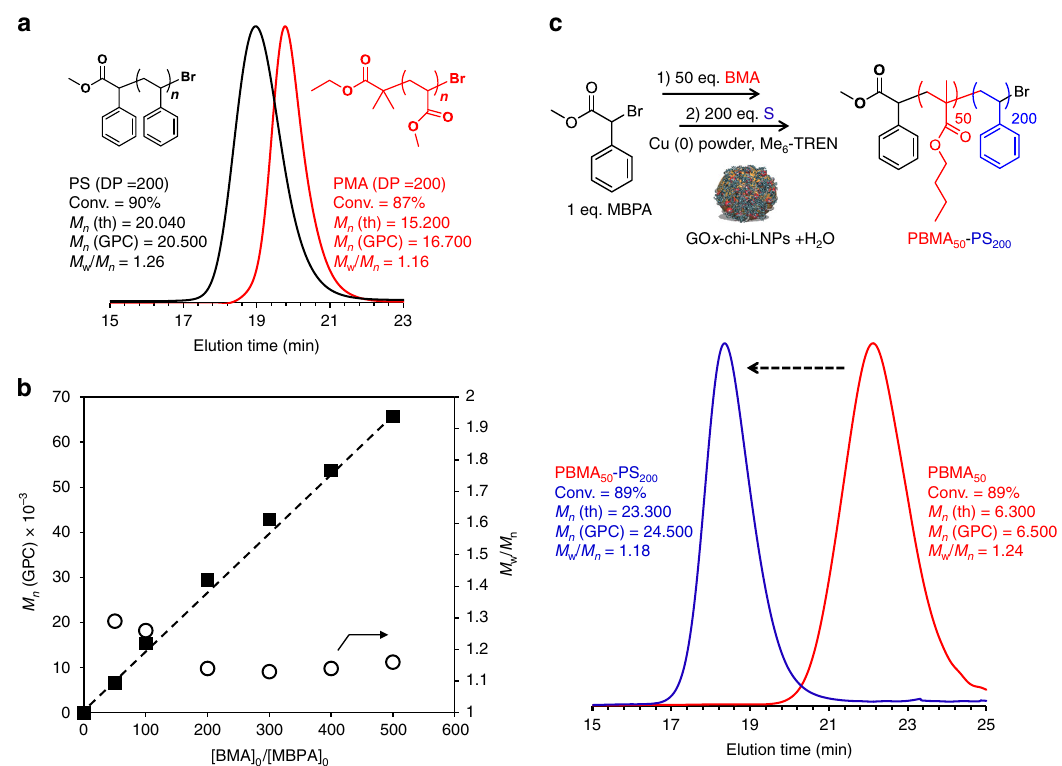
Fig. 4 Expanding the monomer scope and synthesis of block copolymers. a GPC curves of poly(methyl acrylate) (PMA) and polystyrene (PS) obtained by enzyme-degassed Pickering emulsion SET-LRP. Reaction conditions: [Monomer] 0 /[MBPA or EBiB] 0 /[Me 6 -TREN] 0 /[Cu(0)] 0 = 200/1/0.2/0.3. [Lignin nanoparticles] = 2.25 wt% relative to MA or S. b Dependence of experimental M n (GPC) and M w / M n on the [BMA] 0 /[MBPA] 0 ratio. The mean values±SD ( n = 2) of BMA conversion for the different DPs are given in Supplementary Fig. 13, whereas all data points are shown in b . c GPC analysis of block copolymerization via puri fi cation-reinitiation strategy of poly(butyl methacrylate) (PBMA) with styrene (S) to synthetize a PBMA-PS block copolymer. Reaction conditions for the PBMA macroinitiator: [BMA] 0 /[MBPA] 0 /[Me 6 -TREN] 0 /[Cu(0)] 0 = 50/1/0.2/0.3. [GOx-chi-LNPs] = 2.25 wt% relative to higher content of GOx-chi-LNPs (6 wt% relative to BMA) (Supplementary Fig. 15a). SEM analysis of the surface and cross-sections of PBMA-GOx-chi-LNPs fi lm composites (Sup- plementary Fig. 15b, c) con fi rmed the uniform distribution of